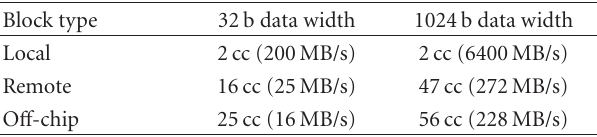
Table 3: BSN latency and bandwidth for each block type